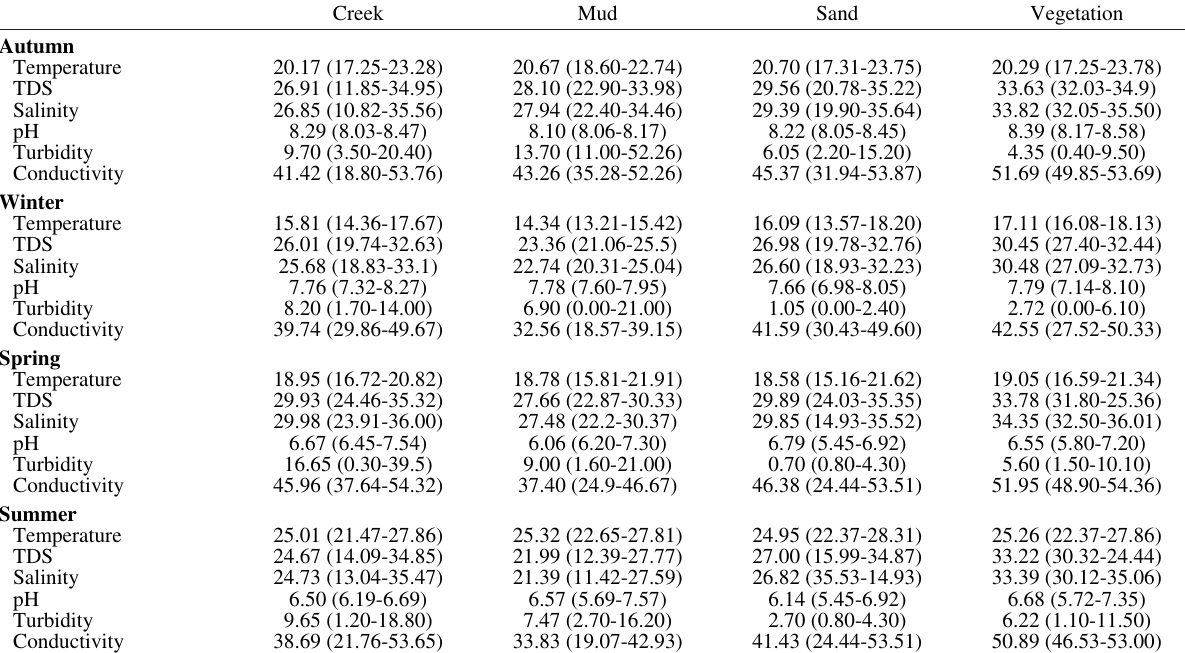
Table 1. – Summary statistics of physico-chemical variability among the four habitat types and seasons in the Swartkops Estuary, February 2013 - January 2014. Statistics represented as mean; range (minimum - maximum). Creek Mud Sand Vegetation Autumn